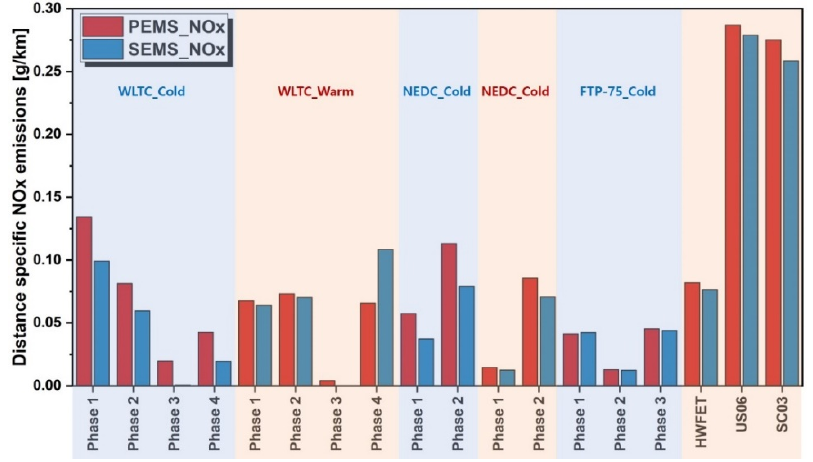
Figure 10. NOx emissions measured by the PEMS and SEMS equipment under various test modes in the laboratory.